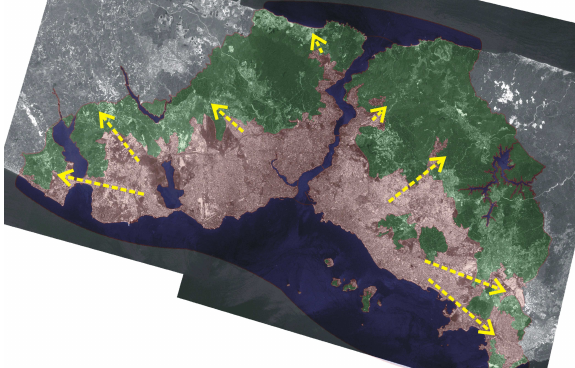
Figure 9: The directions, where the increase might be orientated. The length of the arrows shows the intensity.